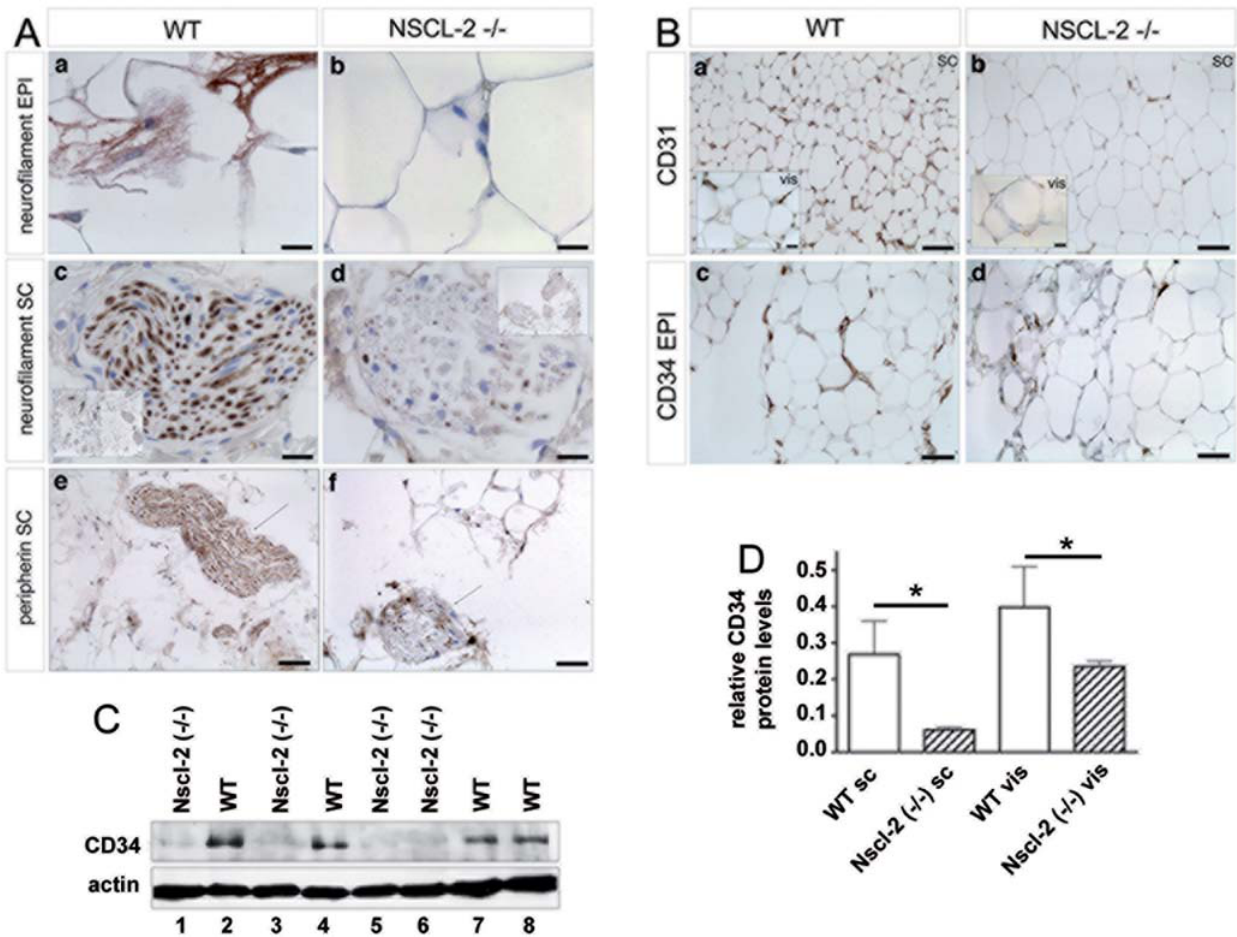
Figure 1. Reduced innervation and vascularization of WAT in Nscl-2 deficient mice. (A) Paraffin sections of WAT from wild-type (WT) and Nscl-2 2 / 2 mice stained with an antibody against neurofilament (a–d) and peripherin (e, f). (a, b) sections through epididymal fat; (c–f) sections through nerve fascicles within subcutaneous fat tissue. Scale bars in (a–d) 15 m m, in the small pictures in (c, d) 100 m m and in (e, f) 50 m m. (B) Reduced vascularization of subcutaneous (SC) and epididymal (vis) fat tissue of Nscl-2 mutants. Immunostainings for endothelial cell markers CD31 (a, b) and CD34 (c, d). Scale bars: 50 m m and in small pictures in (a, b) 15 m m. (C) Western blot analysis of CD34 protein expression in epididymal and paired subcutaneous inguinal adipose tissue of wild-type and Nscl-2 knockout mice. Actin was used as a loading control. (D) Quantification of Western blot analysis of CD34 protein expression in epididymal and paired subcutaneous inguinal adipose tissue of wild-type and Nscl-2 knockout mice. Actin was used as a loading control.